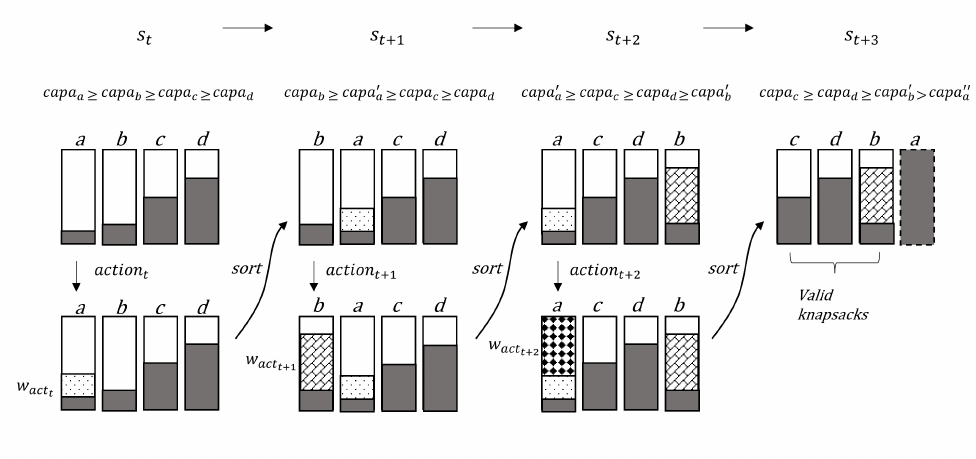
Figure 2. Capacities of knapsacks in each